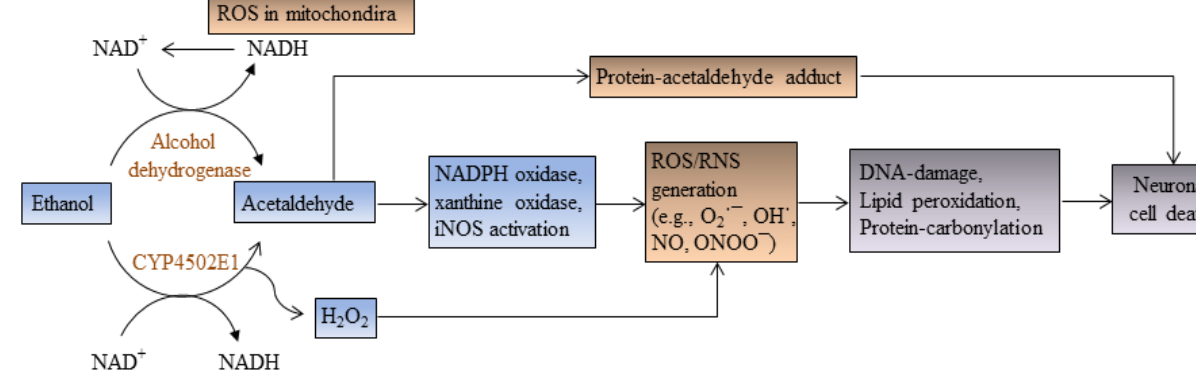
Figure 2. In ethanol metabolism, the enzyme alcohol dehydrogenase oxidizes ethanol to acetaldehyde, while cytochrome P450-2E1 enzyme converts ethanol to acetaldehyde and H O . Acetaldehyde interacts with proteins and forms protein-acetaldehyde adducts 2 2 (acetaldehyde-hemocyanin adduct). Hydrogen peroxide and acetaldehyde (via transcriptional activation of NADPH oxidase, xanthine oxidase, and iNOS) generate free radicals (reactive oxygen species, ROS/reactive nitrogen species, RNS), which oxidize proteins, lipids, and DNA leading to apoptotic cell death in the developing